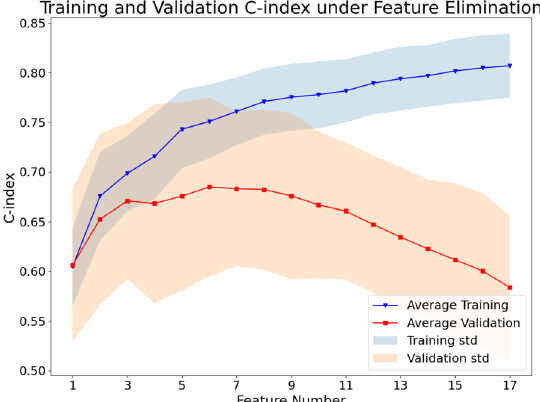
Figure 1. Changes in the training and validation C-indexes with respect to feature numbers in the step-wise backward feature elimination method under three-fold cross-validation, repeated 10 times. The points indicate the averaged C-index over cross-validation folds, and the shaded area indicates the range of one standard deviation (std).